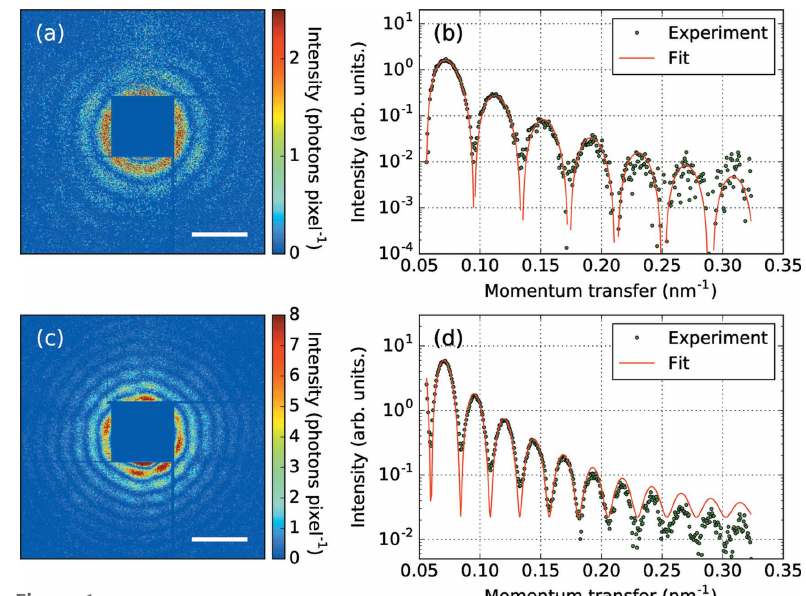
Figure 1 Measured diffraction patterns from Xe clusters. ( a ) A concentric ring pattern suggesting a spherical cluster. ( b ) The 1D scattering intensity deduced from the pattern ( a ) and a fitting curve. ( c ) A pattern consisting of concentric rings with aperiodic intensity modulation suggests existence of a cluster having surface structures. ( d ) The 1D scattering intensity deduced from the pattern ( c ) and a fitting curve. The scale bars in ( a ) and ( c ) are 0.1 nm (cid:4) 1 Figs. 1( a )–1( d ) show diffraction patterns of Xe clusters recorded with the octal MPCCD sensor. The central region of the diffraction patterns is missing because of the intense stray light signal from upstream X-ray optics. Most of the obtained diffraction patterns consist of concentric rings corresponding to spherical clusters [Fig. 1( a )]. In addition, there were a few patterns suggesting spheroidal clusters and interference patterns associated to two particles being present in the focus, as reported in earlier works (Bostedt et al. , 2010; Rupp et al. , 2012; Gorkhover et al. , 2018).